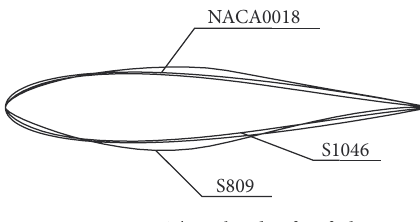
Figure 1: Three kinds of airfoil.